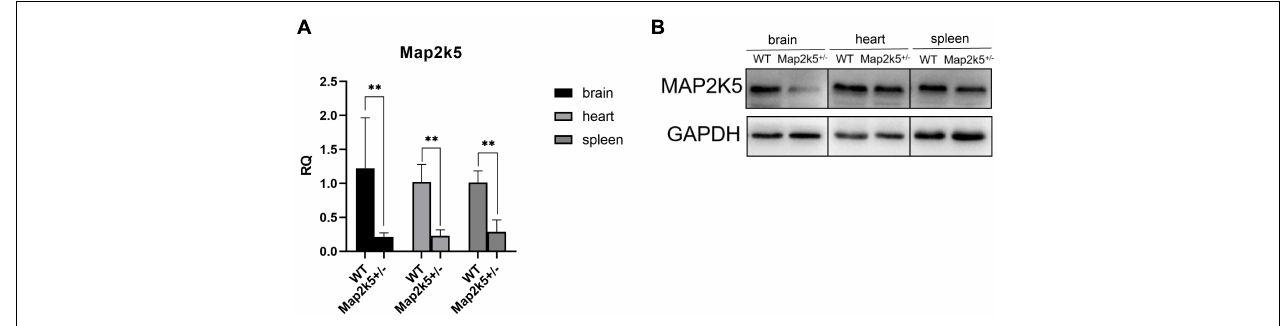
FIGURE 2 | (A) Map2k5 + / − heterozygous mice expressed 20–30% relative quantitative (RQ) levels of intact Map2k5 mRNA in the brain, heart, and spleen ( t -test, n = 6). Bars represent means with standard errors of the mean (SEM). (B) Western blot of Map2k5 expressions in different tissues (brain, heart, and spleen) in WT and Map2k5 + / − mice. ** P <